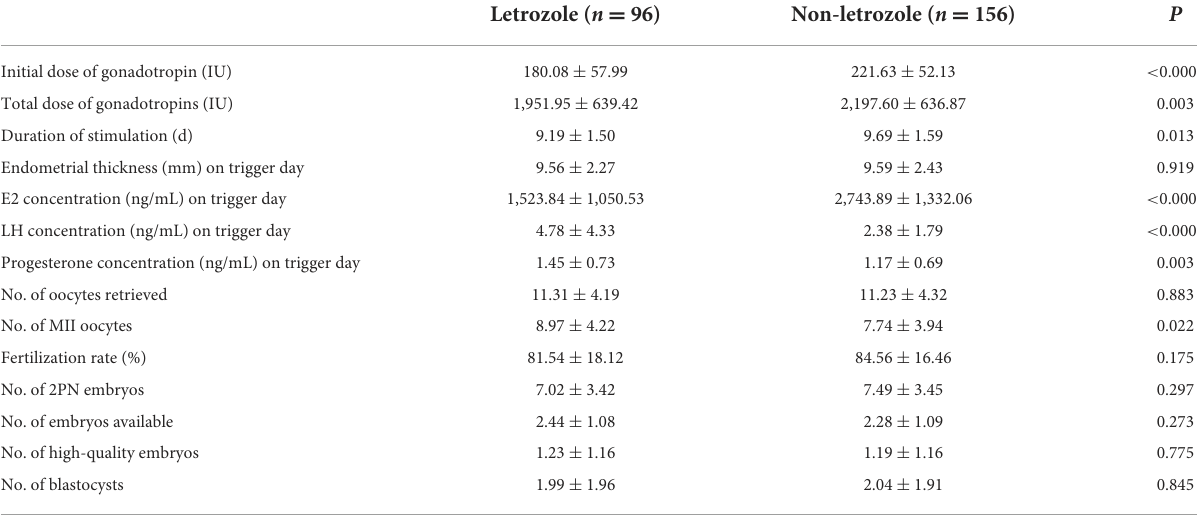
TABLE 2 Comparison between letrozole and non-letrozole groups: characteristics of ovarian stimulation. Letrozole ( n = 96) Non-letrozole ( n = 156) P